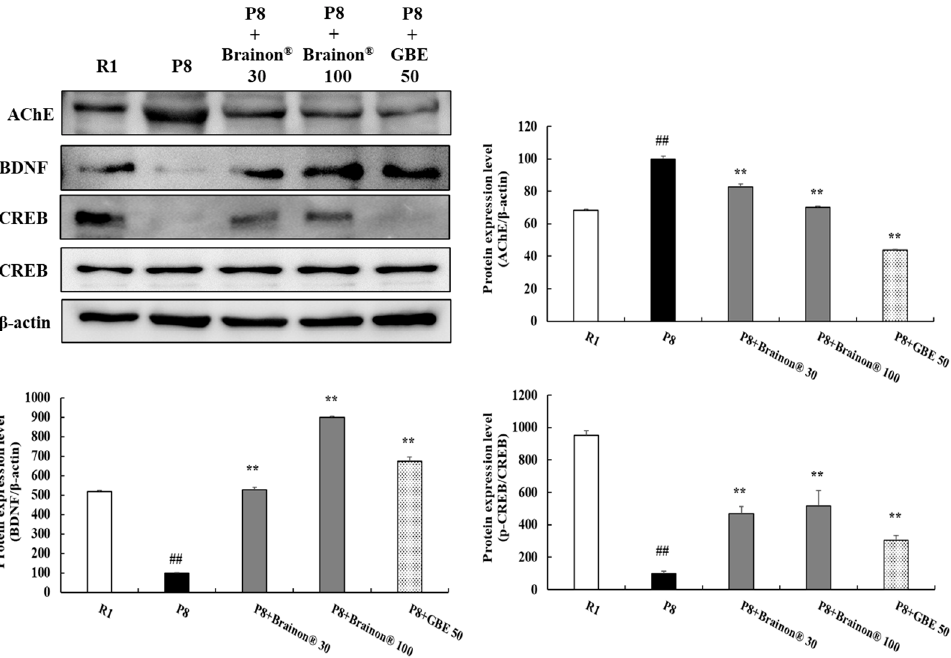
Figure 10. Brainon ® inhibits AChE activity but increases BDNF expression and CREB phosphorylation levels in the cerebral cortex of SAMP8 mice. AChE (68 kDa), BDNF (15 kDa), p-CREB (43 kDa), and CREB (43 kDa) protein levels were analyzed using Western blotting. The density of each protein band was measured using the ImageJ program. Protein was normalized with β -actin (45 kDa). Values are presented as mean ± SD ( n = 3). ## p < 0.01 vs. R1 (SAMR1) group; ** p < 0.01 vs. P8 (SAMP8) group.